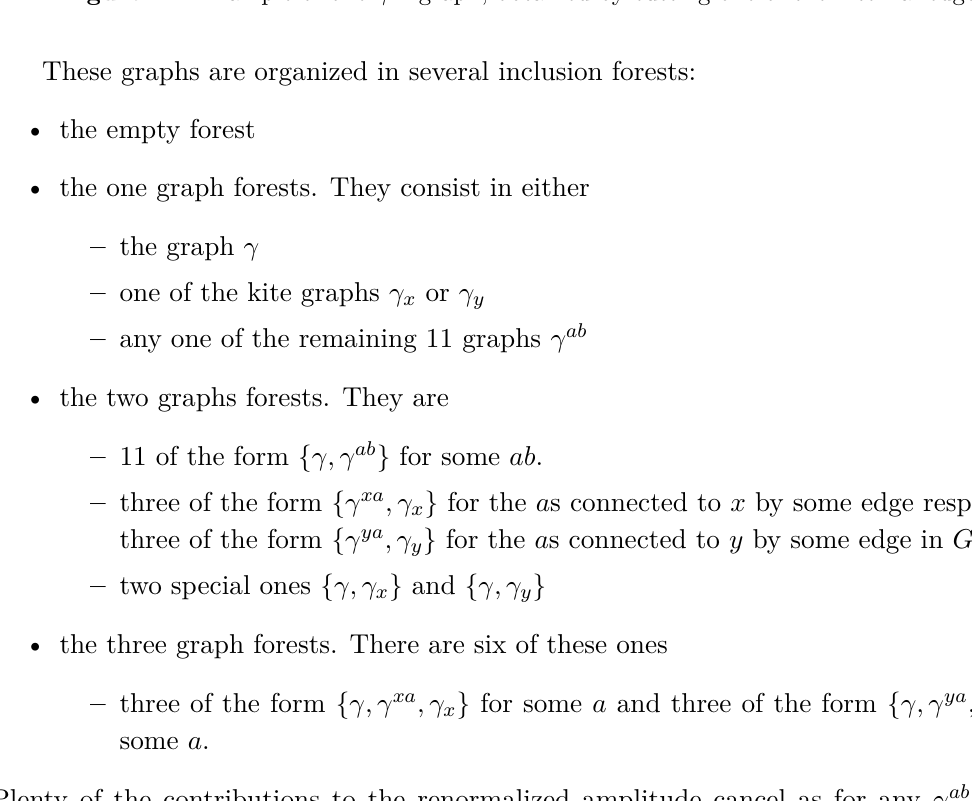
Figure 14 . Example of one γ ab graph, obtained by cutting one of the internal